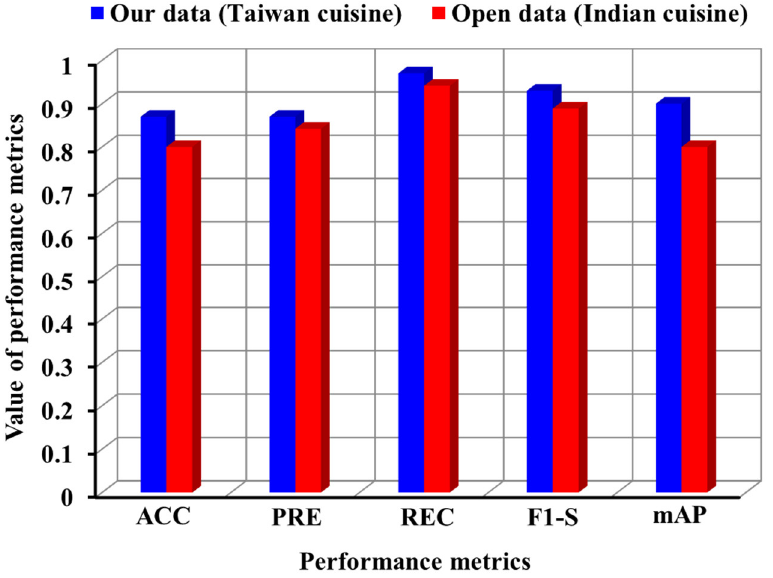
Figure 6. Comparison of performance metrics between our data with open dataset.